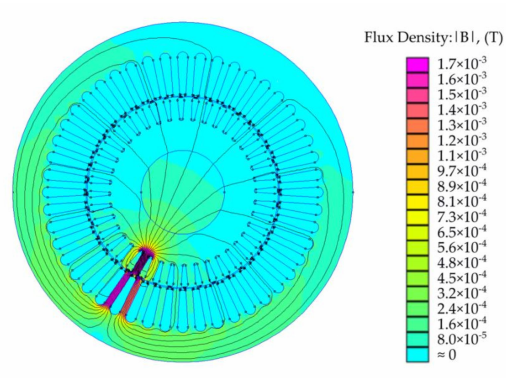
Figure 5. Flux distribution due to energized rotor loop with I DC = 1 A for the calculation of rotor